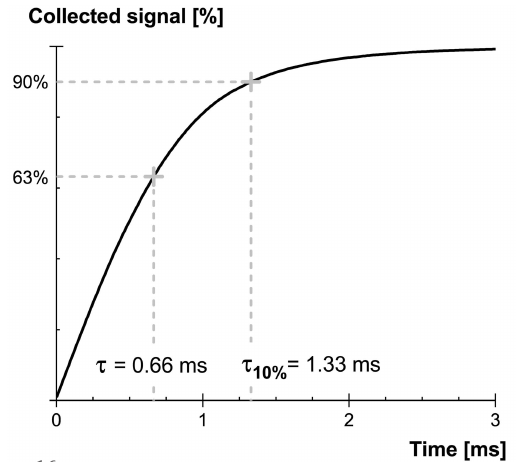
Figure 16 Collected signal as a function of the integration time for GOS:Tb